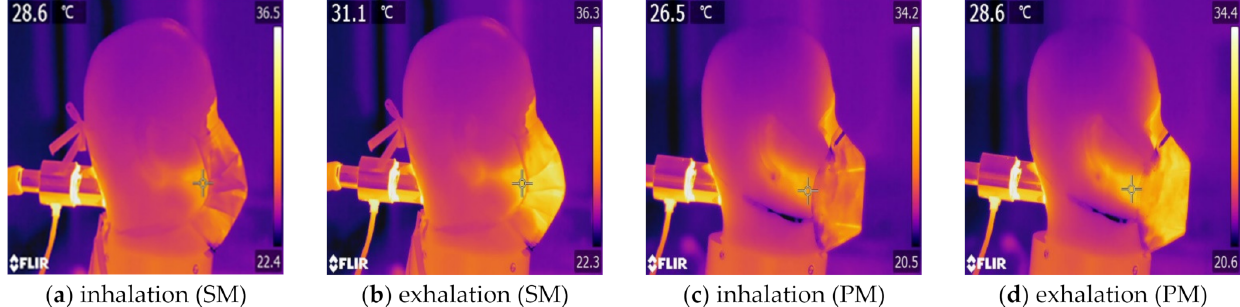
Figure 11. Lateral view, thermal infrared images of breathing while wearing a mask for 8 h (the temperature in degrees Celsius at the marker is indicated in the upper-left